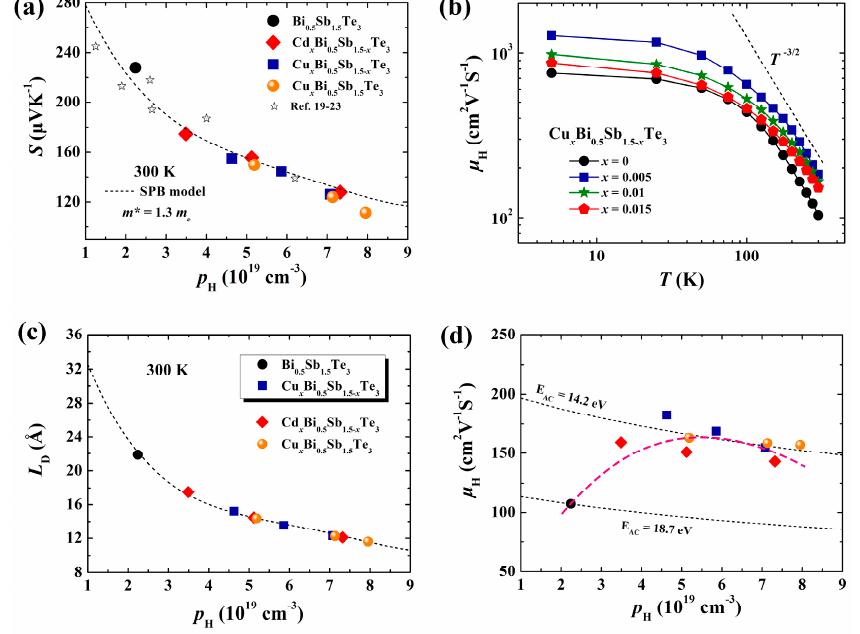
Figure 4. ( a ) The theoretical and experimental Pisarenko plots for Cu-doped Bi 0.5 Sb 1.5 Te 3 samples. The data of Cd-doped Bi 0.5 Sb 1.5 Te 3 samples and some other Bi 0.5 Sb 1.5 Te 3 samples previously reported [19–23] are also shown for comparison; ( b ) temperature dependence of Hall mobility µ H for Cu-doped samples; ( c ) the Hall hole concentration p H dependences of the calculated Debye screen length L D ; and ( d ) the mobility µ H for Cu-doped Bi 0.5 Sb 1.5 Te 3 samples. The data of Cd-doped Bi 0.5 Sb 1.5 Te 3 samples are included for comparison. The dashed line in ( d ) is provided as a guide for eyes. The dotted lines in ( d ) represent the theoretical trends predicted by acoustic phonon scattering mechanism with different deformation potential E AC .